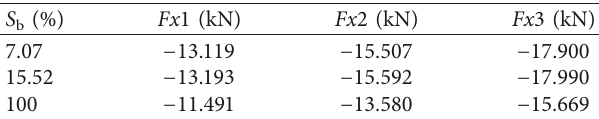
Table 5: Longitudinal force on the tire at some typical slip ratios during braking.